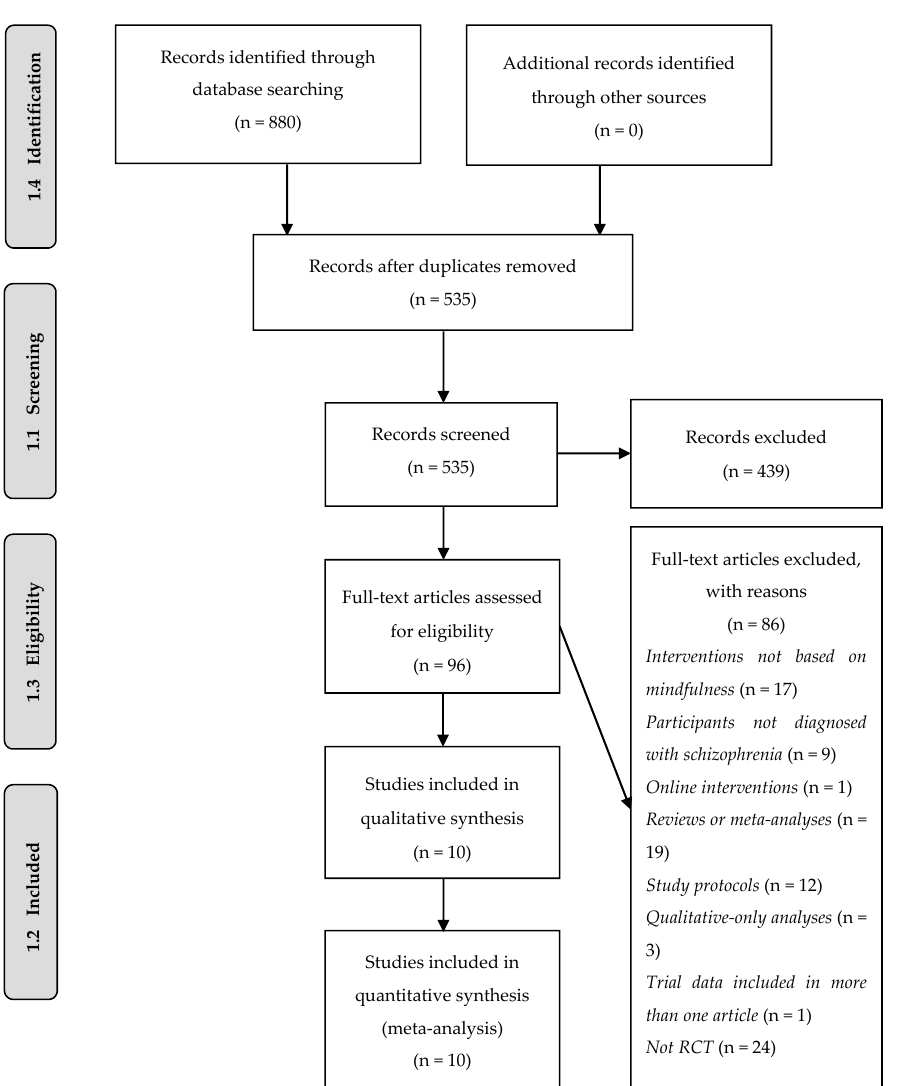
Figure 1. Search and selection of articles in PRISMA flow